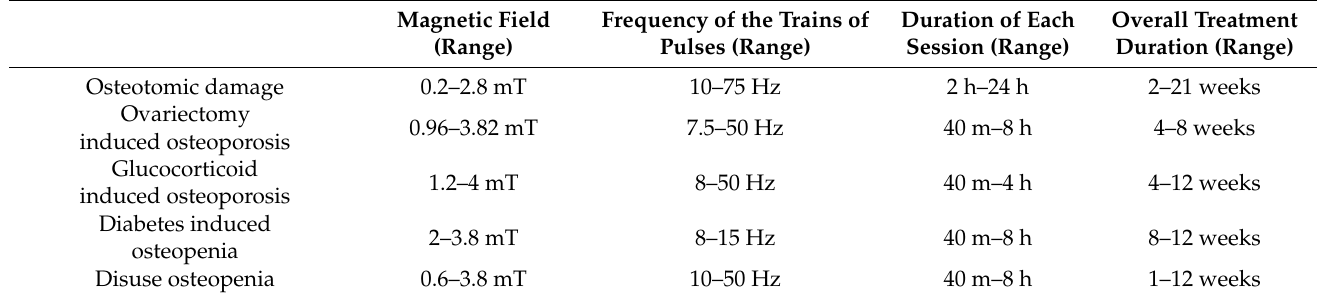
Table 2. Range of parameter settings proven efficient in PEMF stimulation, divided according to different bone damage models studied. Magnetic Field Frequency of the Trains of Duration of Each Overall (Range) Pulses (Range) Session (Range)